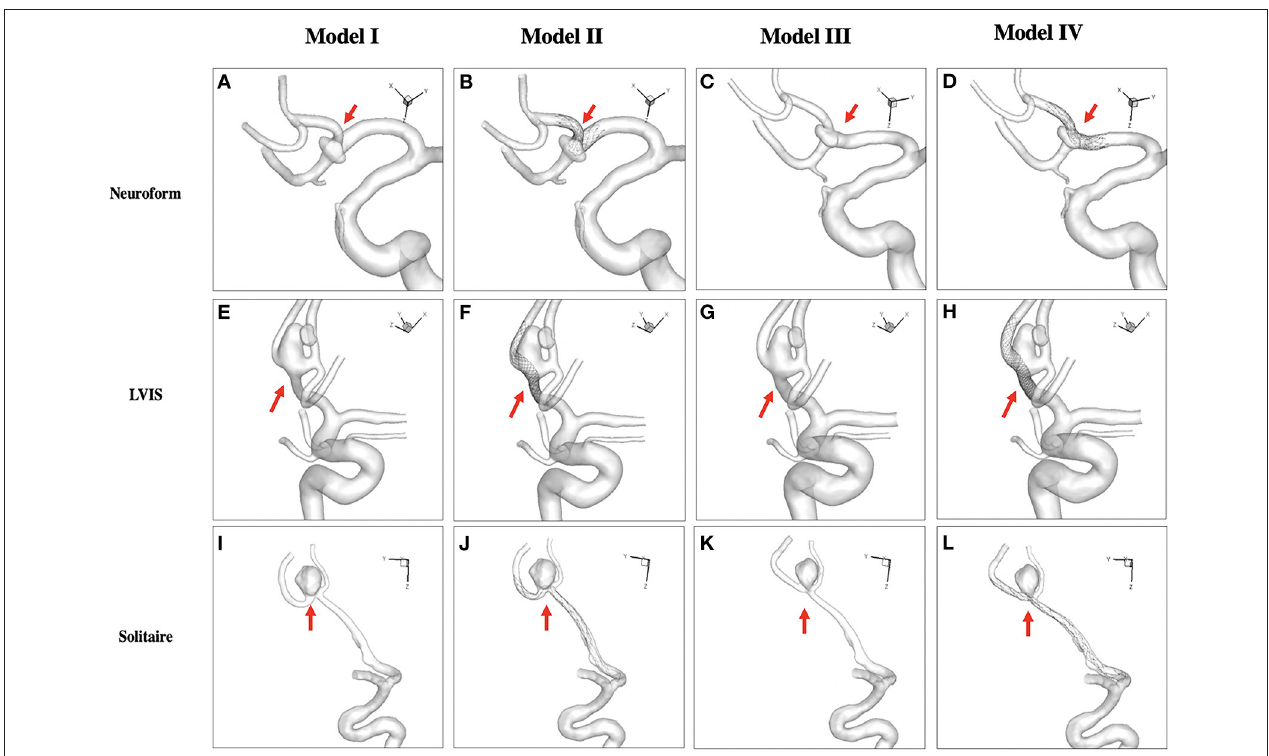
FIGURE 1 | Four models of each stent (Neuroform stent, A-D ; LVIS stent, E-H ; Solitaire stent, I-L ) were simulated. Pre-treatment (Model I, A,E,I ), stenting without straightening (Model II, B,F,J ) presented as the stent-mesh effect, no-stent with reconstruction (Model III, C,G,K ) to reveal the straightening effect, and stenting with straightening (Model IV, D,H,L ) were